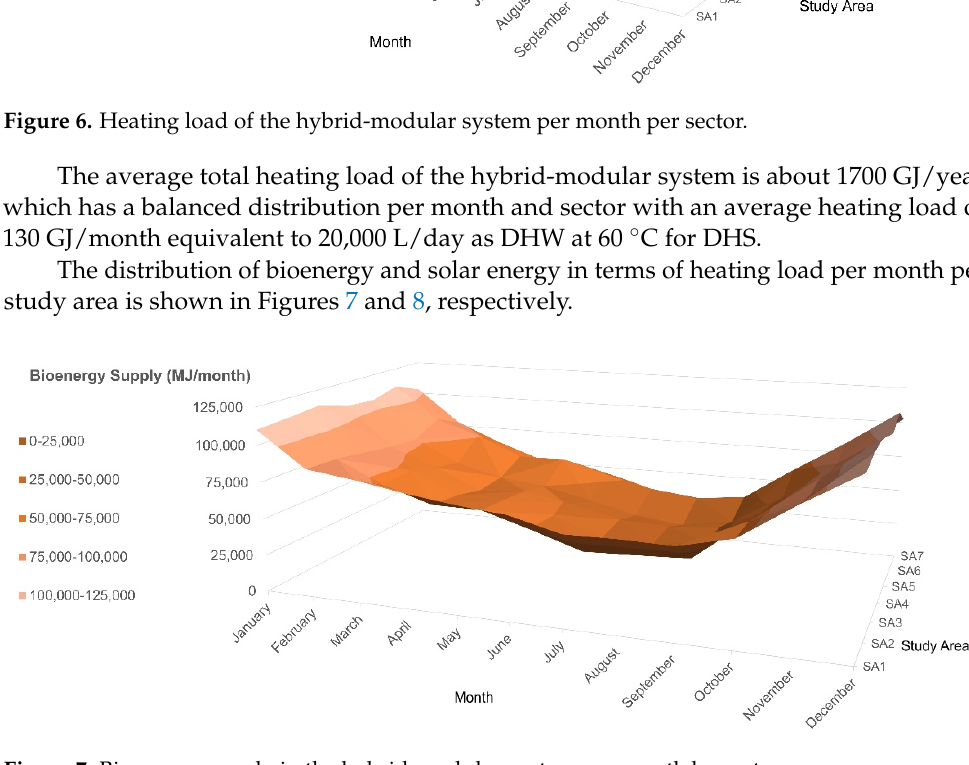
Figure 6. Heating load of the hybrid-modular system per month per sector.